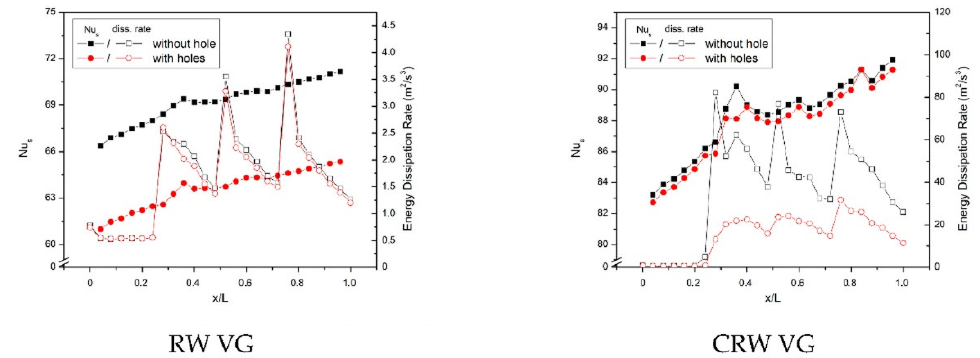
Figure 11. Local average spanwise Nusselt number and energy dissipation rate at the flow velocity of 2.0 m/s.